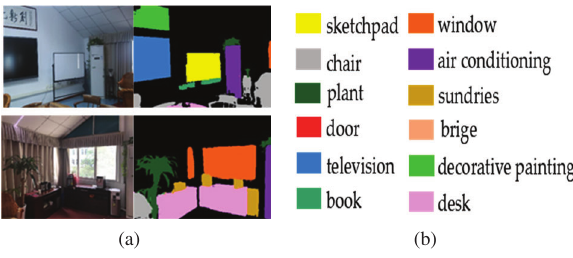
Figure 8. Dataset of meeting room.(a) shows the RGB images we collected;(b) shows the corresponding 3D point cloud. Figure 10. The semantic segmentation result with our proposed SLENet. (a) shows the input image and semantic segmentation results of our network. (b) shows the segmentation legend of SLENet.